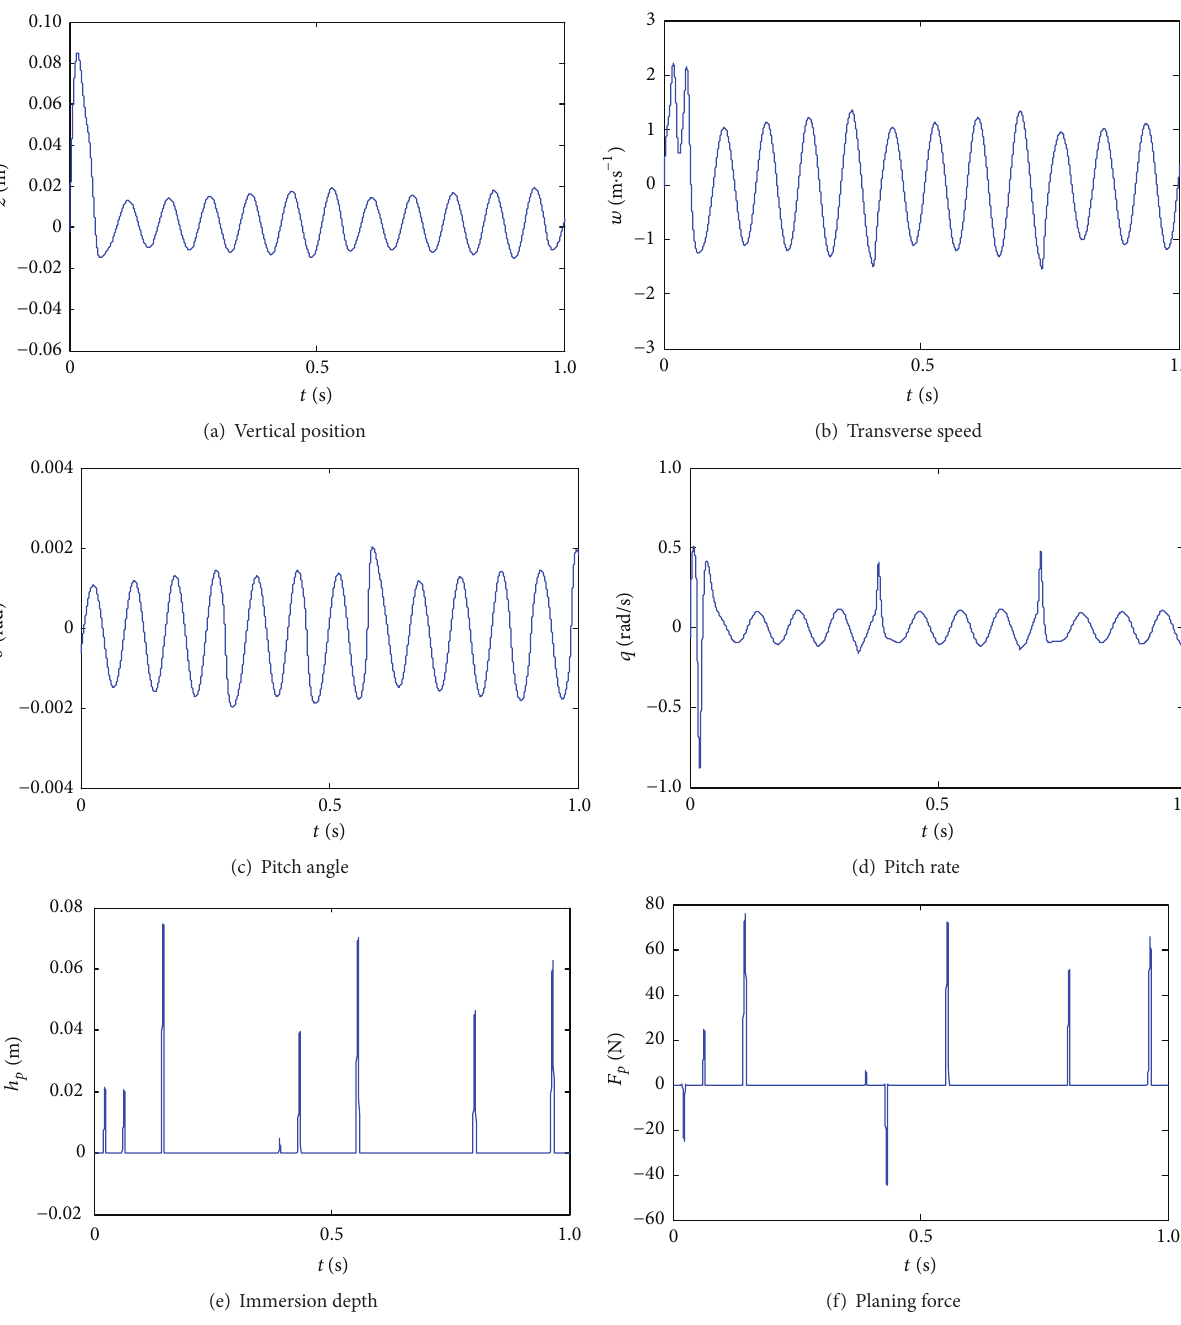
Figure 12: The motion state of the system when 𝑘 = 55